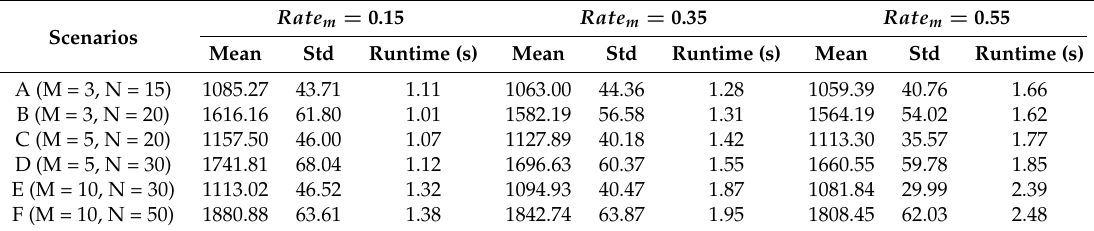
Table 2. Performance comparison of MGA with different mutation